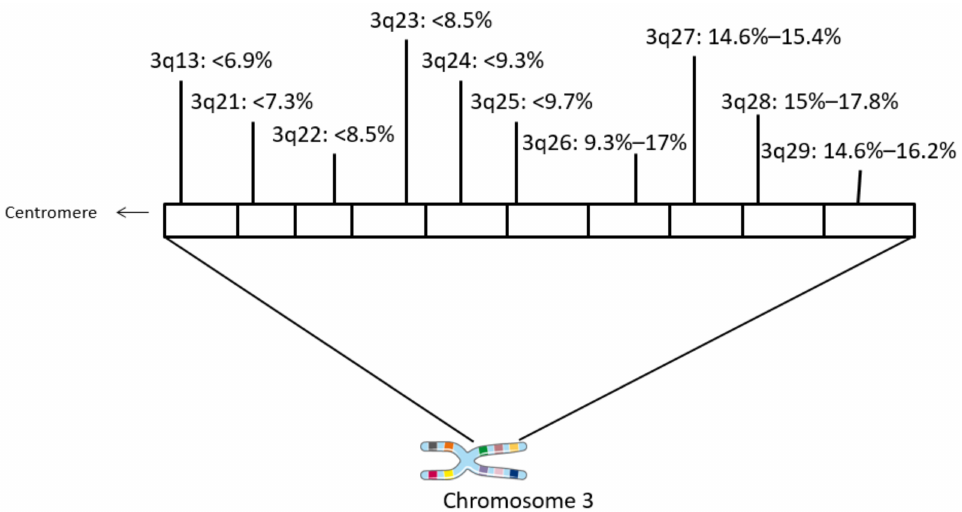
Figure 1. Schematic of chromosome 3q with frequencies of amplification in different loci in squamous cervical carcinomas. Data are from TCGA cervical